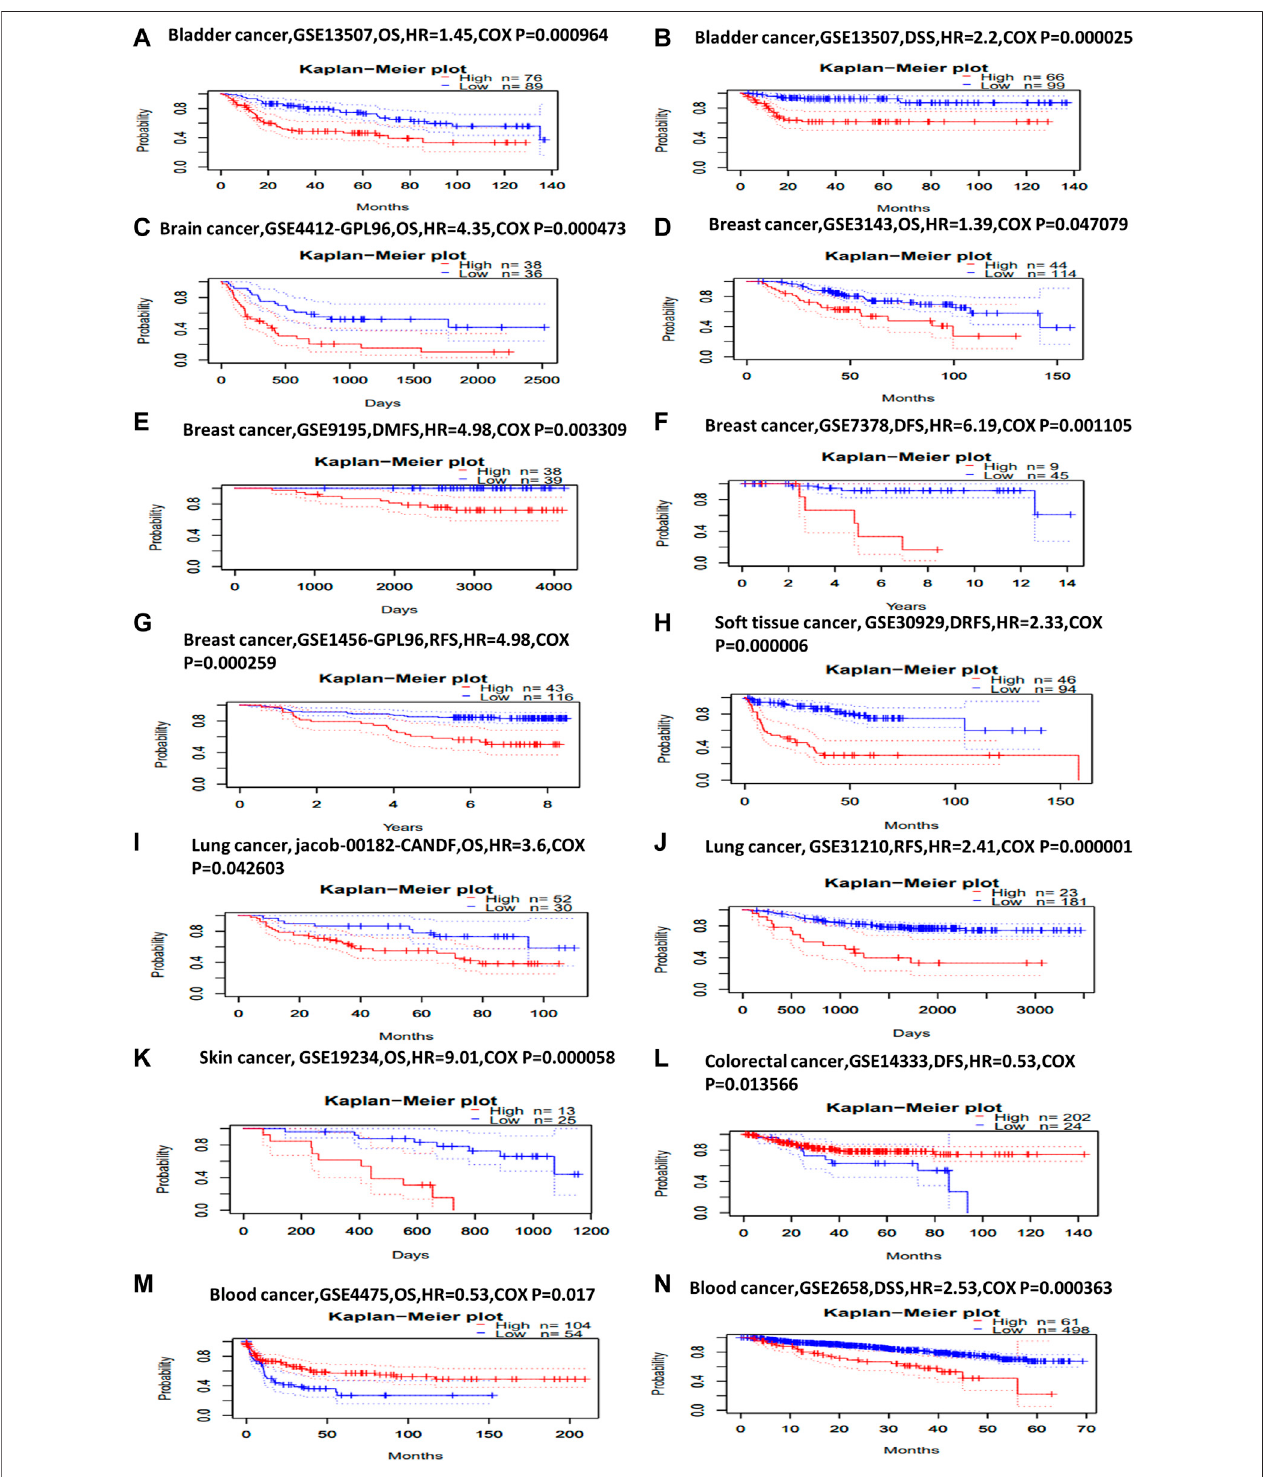
FIGURE2| Kaplan – Meiersurvivalcurvescomparinghigh and lowexpression of KIF2C indifferentcancertypes inPrognoScan. (A) OS( n =165)inbladdercancer cohort GSE13507. (B) DSS ( n = 165) in bladder cancer cohort GSE13507. (C) OS ( n = 74) in brain cancer cohort GSE4412-GPL96. (D) OS ( n = 158) in breast cancer cohort GSE3143. (E) Distant metastasis-free survival ( n = 77) in breast cancer cohort GSE9195. (F) DFS ( n = 54) in breast cancer cohort GSE7378. (G) RFS ( n = 159) in breast cancer cohort GSE1456-GPL96. (H) Distant relapse-free survival ( n = 140) in soft-tissue cancer cohort GSE30929. (I) OS ( n = 82) in lung cancer cohort jacob-00182-CANDF. (J) RFS( n =204)inlungcancercohortGSE31210. (K) OS( n =38)inskincancercohortGSE19234. (L) DFS( n =226)incolorectal cancercohort GSE14333. (M) OS ( n = 158) in blood cancer cohort GSE4475. (N) DSS ( n = 559) in blood cancer cohort GSE2658.